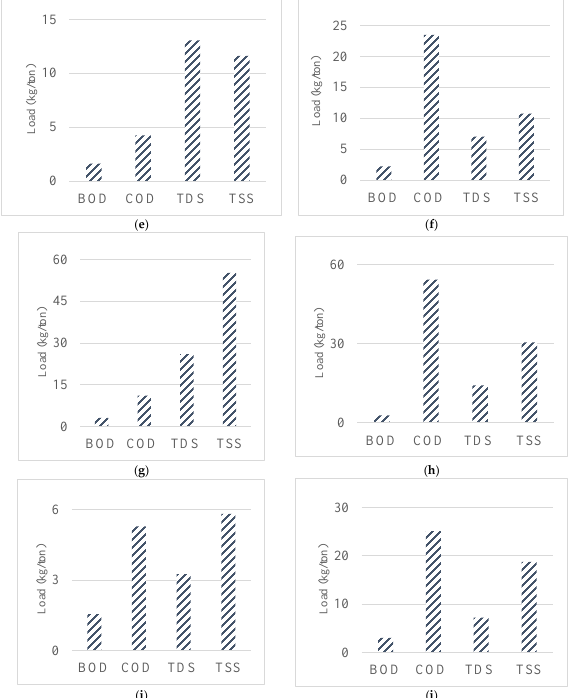
Figure 2. Pollution load of ( a ) soaking, ( b ) liming stage of beam house operations post tanning op- erations, ( c ) deliming and bating, ( d ) pickling and tanning stage of tan yard operations and ( e ) wet back, ( f ) rechroming ( g ) neutralization, ( h ) retanning, ( i ) dyeing and ( j ) fatliqouring in leather pro- duction .